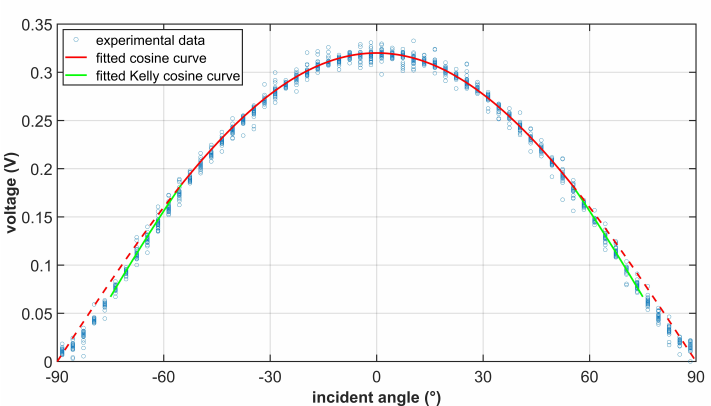
Figure 5. Sampled voltage curve of a solar cell with various incident angles. The proposed empirical formula fits the experimental data well. A 2 − ohm precise resistor is connected in series to measure the